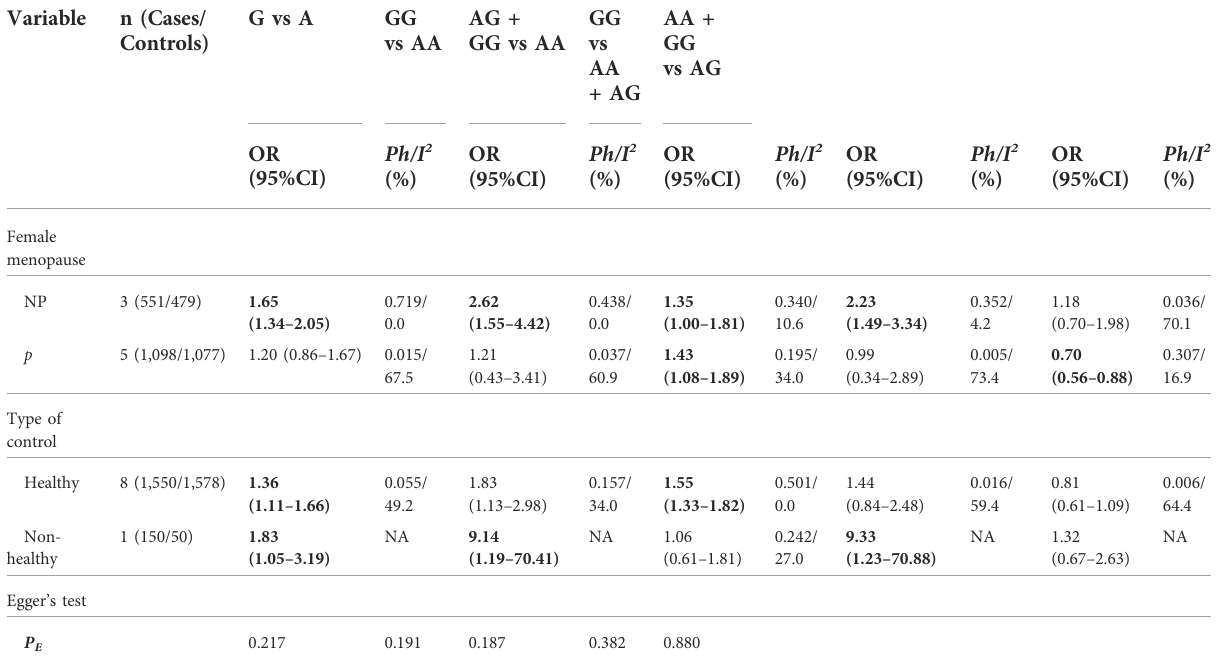
Table 4 and Figure 3) and female (C vs G: OR = 0.85, 95% CI